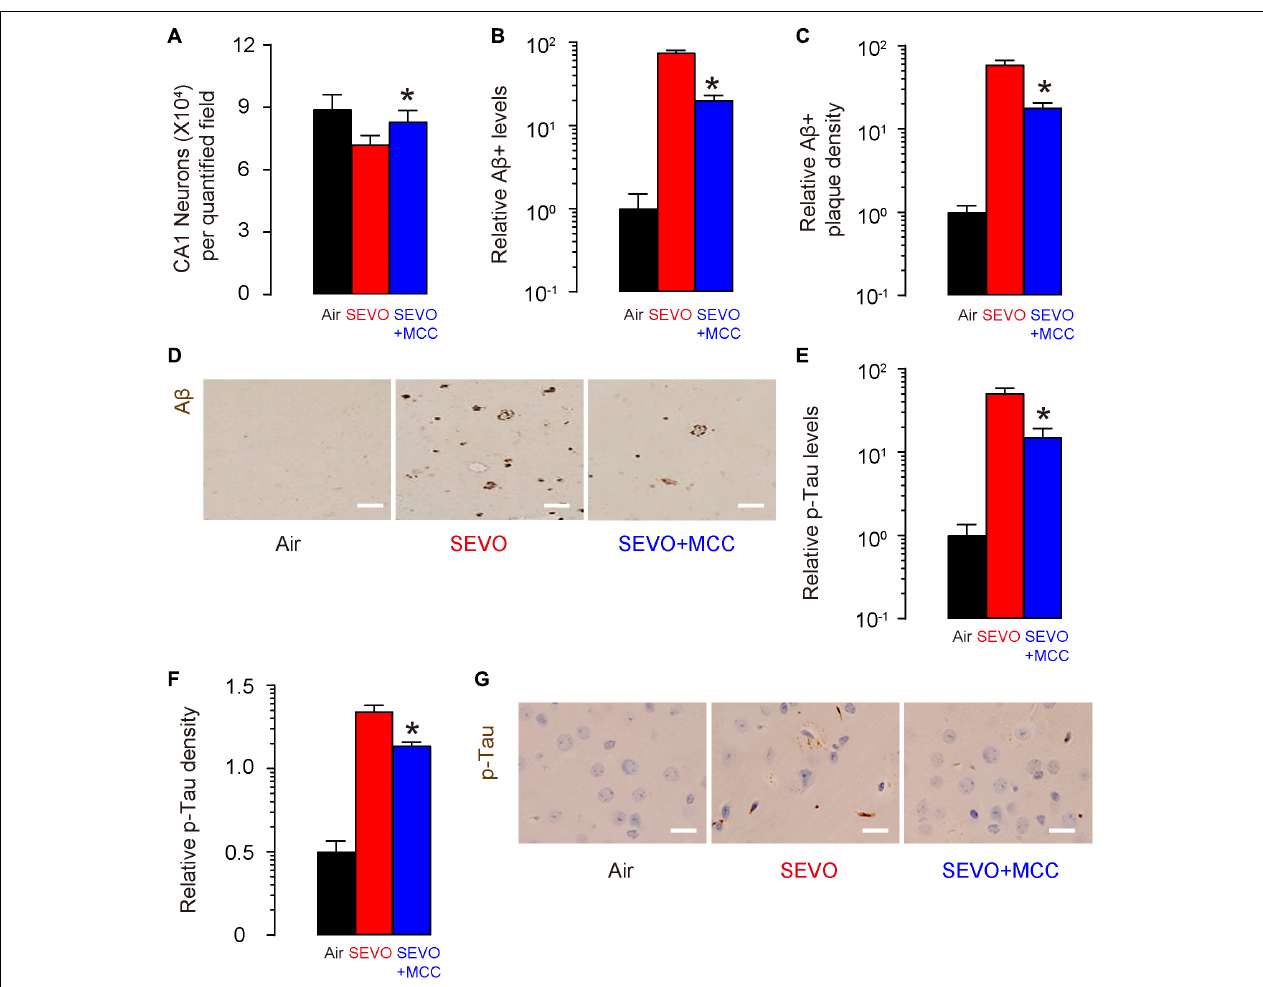
FIGURE 5 | Suppression of NLRP3 attenuates SEVO-mediated loss of neuronal cells, A β deposition, and p-Tau formation in the brain of APP/PS1 mice. (A) Neuron loss in the hippocampus region of APP/PS1 mice at sacrifice (2 months after SEVO exposure and MCC/DMSO treatment and at 5 months of age). (B) ELISA for A β levels in hippocampus from SEVO+MCC mice, compared to SEVO mice. (C,D) A β plaque density in the hippocampus region in SEVO+MCC mice, compared to SEVO mice, shown by quantification (C) and by representative images (D) . (E) ELISA for p-Tau levels in hippocampus from SEVO+MCC mice, compared SEVO mice. (F,G) p-Tau density in the hippocampus region in SEVO+MCC mice, compared to SEVO, shown by quantification (F) and by representative images (G) . * p < 0.05 (SEVO+MCC vs. SEVO). N = 10. N represents mouse number per experimental group. Scale bars are 20 µ